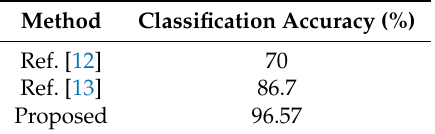
Figure 14. Average character recognition accuracy of all users. Table 6. Comparison of classification accuracy.